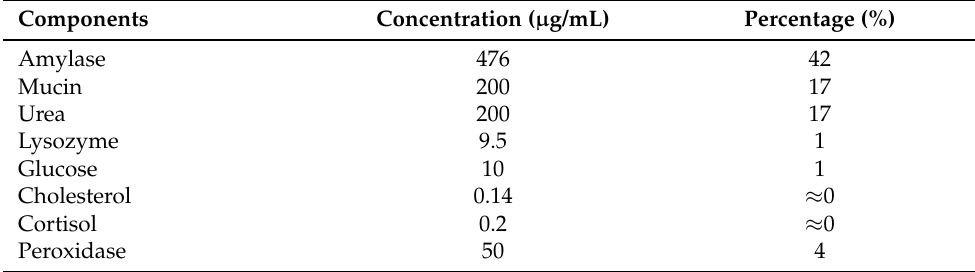
Table 1. Concentration of components in saliva